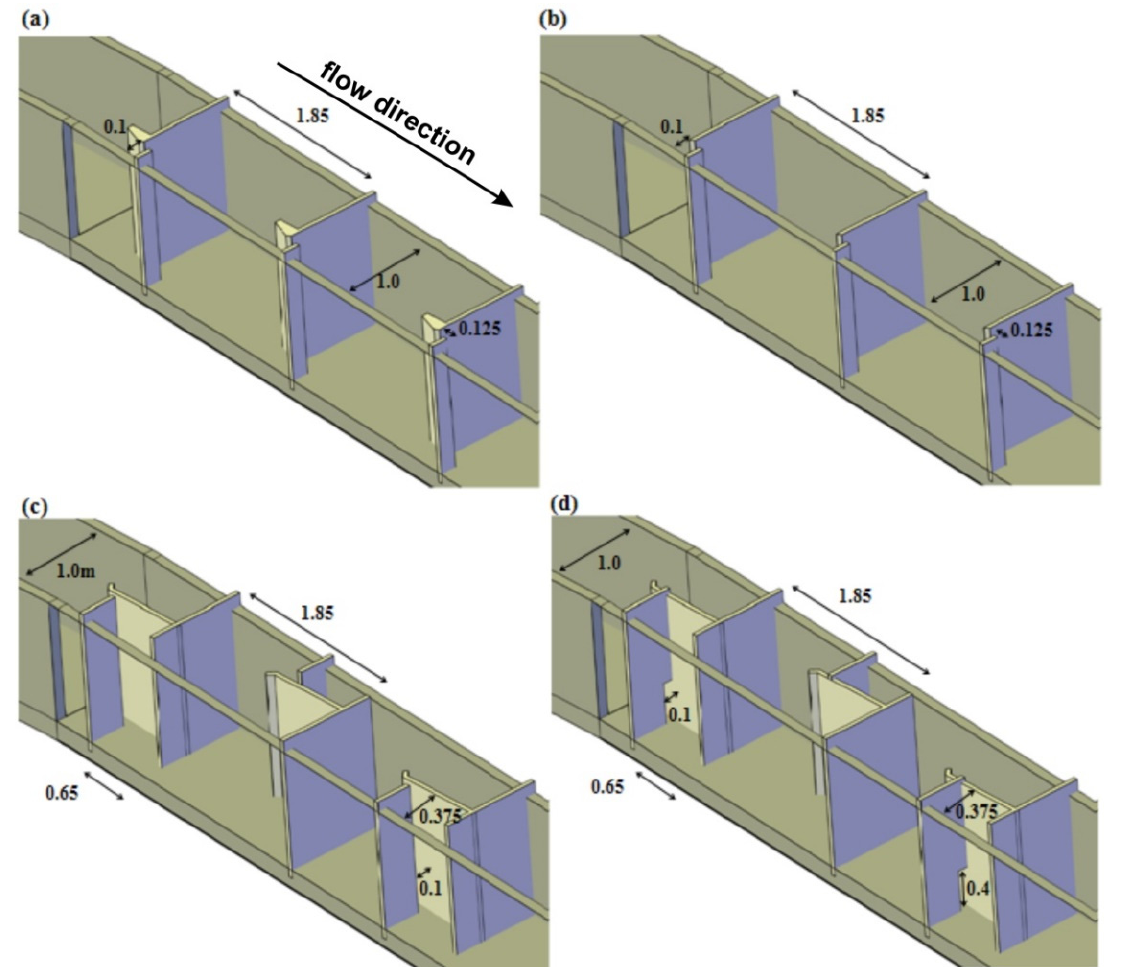
Figure 1. Fishway configurations tested (slope of 8.5%). ( a ) Vertical slot fishway (VSF 1)—discharge (Q) = 112 L·s − 1 ; ( b ) VSF 2—Q = 80 L·s − 1 ; ( c ) multislot fishway (MSF 1)—Q = 58 L·s − 1 ; ( d ) MSF 2—Q = 37 L·s − 1 ) (dimensions in meters).